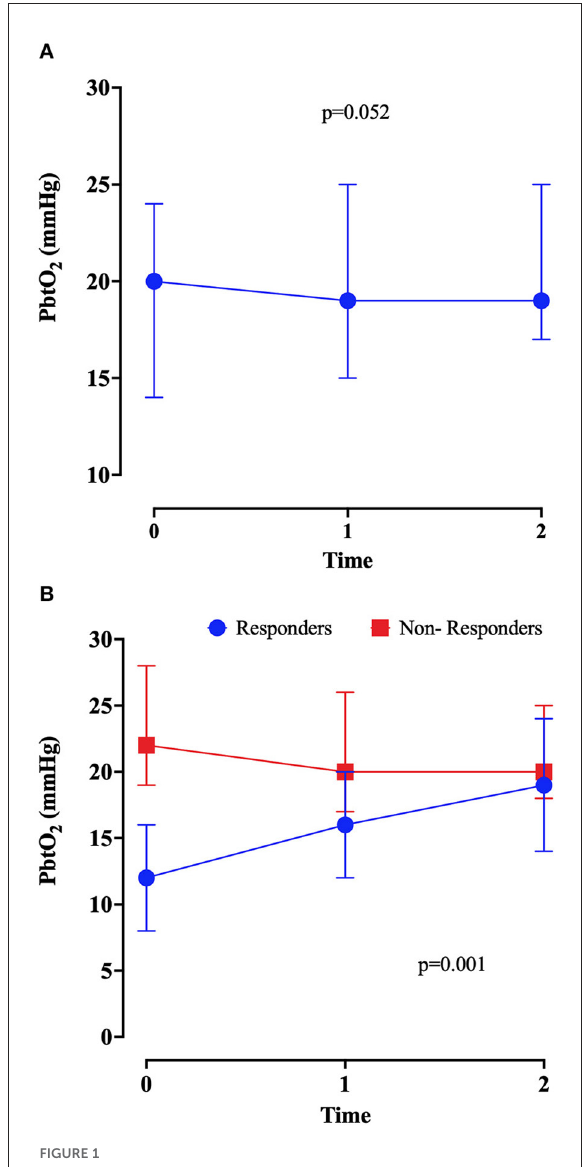
FIGURE1 Brain tissue oxygenation (PbtO 2 ) values at baseline (before initiation of inotropes—T0), at 1 (T1) and 2 (T2) hours after the introduction of inotropic continuous infusion in the overall population (A) and in responders and non-responders (B) . P -value was calculated by Friedmann test.